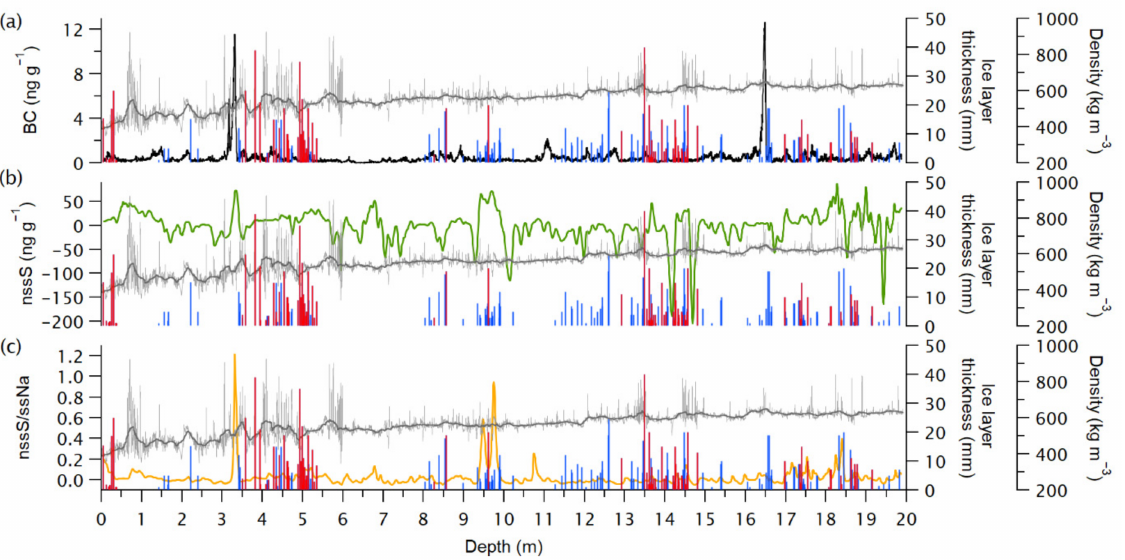
Figure 7. Comparison of OH-12 high-resolution depth records of ( a ) black carbon (BC; black), ( b ) non-sea-salt sulphur (nssS; green) and ( c ) the non-sea-salt sulphur–sea-salt sodium ratio (nssS/ssNa; orange) with the high-resolution density–depth profile (grey; 1500-point running mean in bold) and the ice layer stratigraphy (blue). Ice layers indicating surface melt are highlighted in